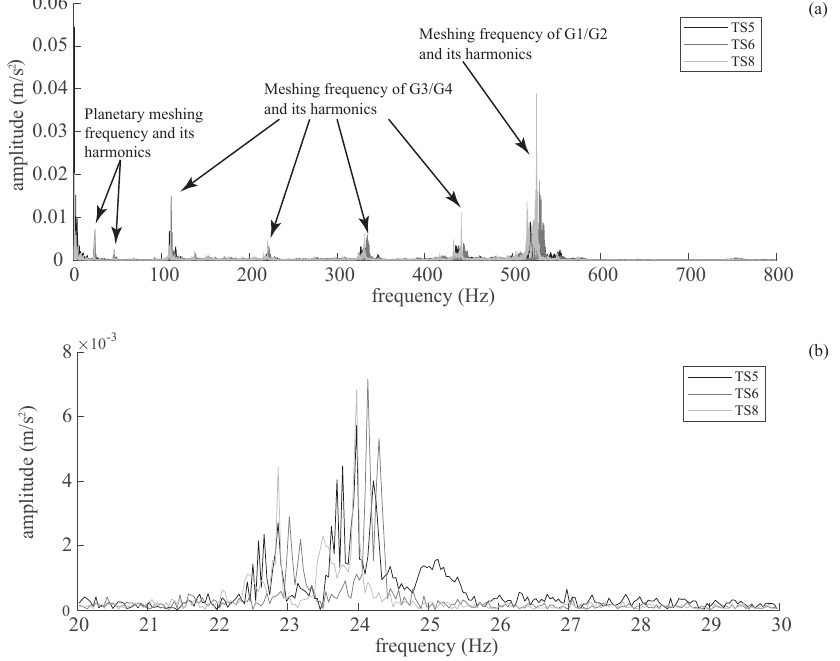
Figure 11. ( a ) Spectra of TS5, TS6 and TS8; ( b ) detail of a planetary meshing